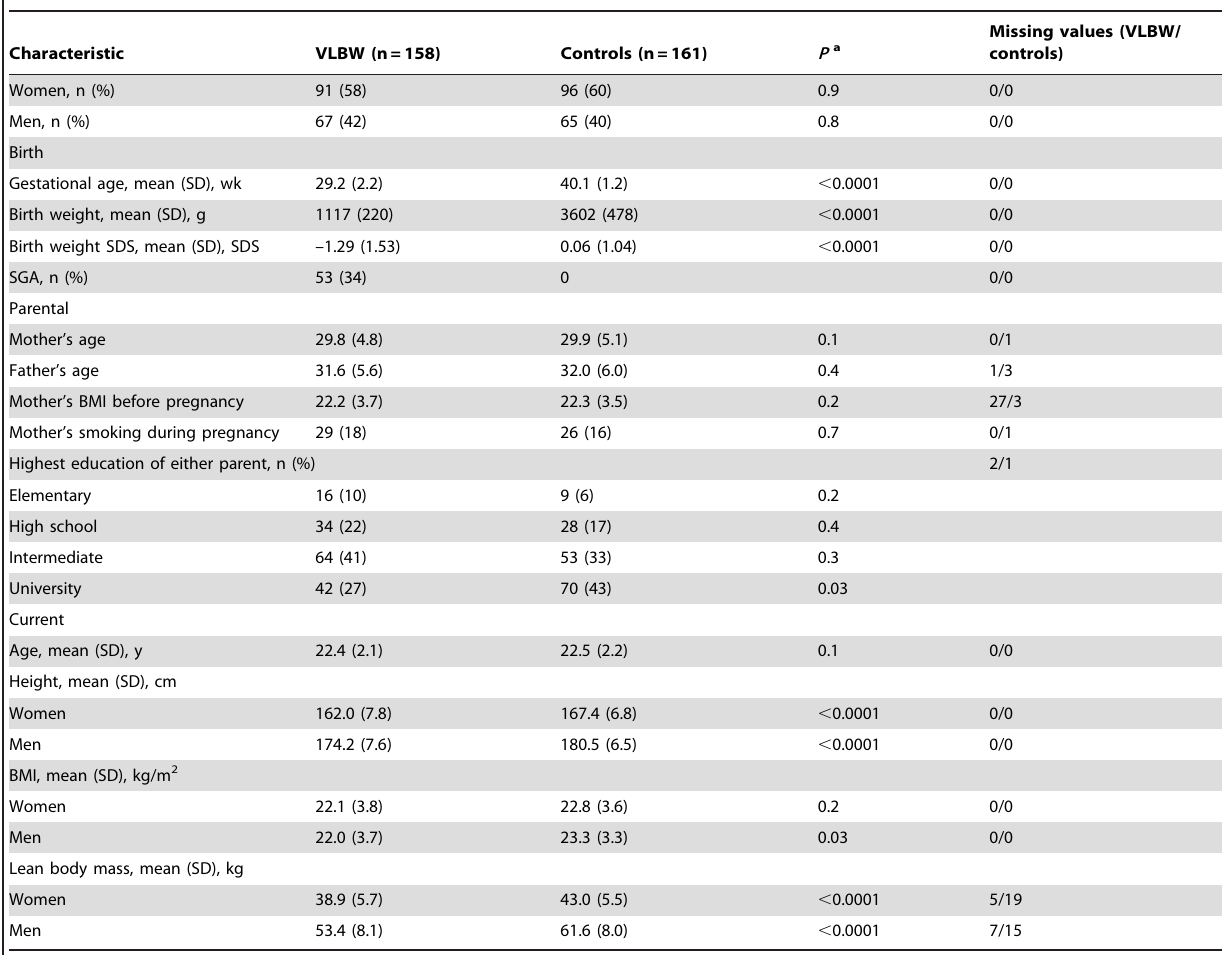
Table 2. Characteristics of the study